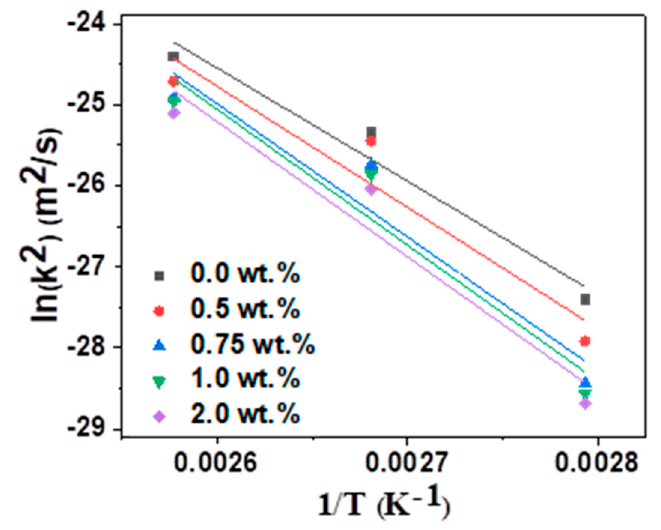
Figure 6. Arrhenius plots of intermetallic compound (IMC) growth rate as a function of Ag NP content of Sn–58Bi solder.